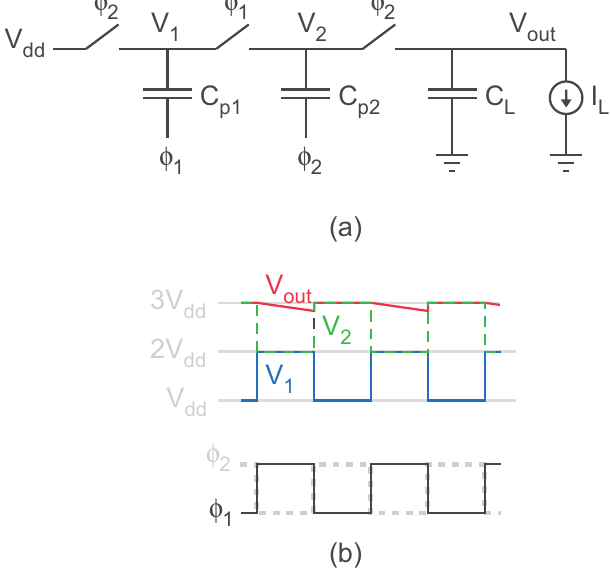
Figure 1. ( a ) Ideal charge pump. ( b ) Operation of the ideal charge